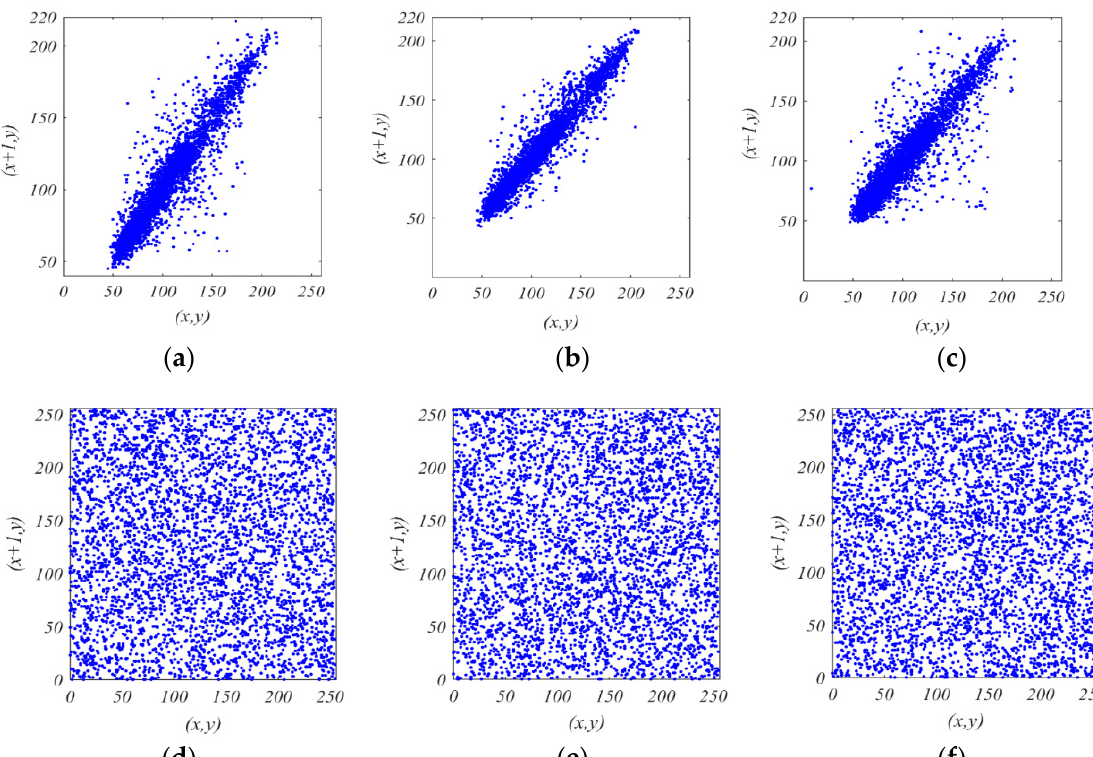
Figure 20. Correlation analysis of the G band of a plain Lena image and its consistent encrypted image: ( a , d ) horizontal correlation, ( b , e ) vertical correlation, ( c , f ) diagonal correlation.